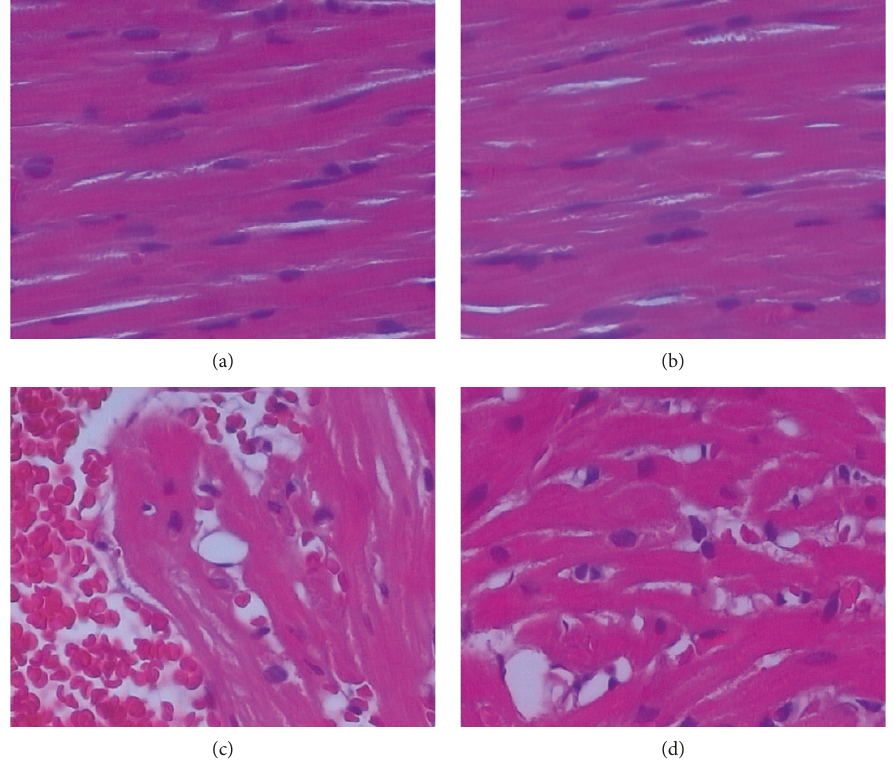
Figure 3: (a) and (b) illustrate the normal appearance of the myocardial structure in the CD group and CD+ SIT group. The myocardial structure in WD mice showed a severe myocardial structure injury, including a loose arrangement of myocardial cell, irregular part of the myocardial fi ber fracture, apparent vacuole degeneration, myocardial interstitial hyperemia and edema, and a small amount of in fl ammatory cell in fi ltration mainly composed of lymphocytes (c). SIT treatment improved the myocardial arrangement, swollen cells, hyperemic edema, and lymphocyte in fi ltration